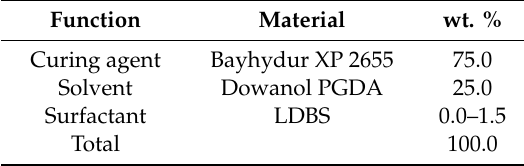
Table 3. Formulation of the waterborne polyurethane coating (hardener).